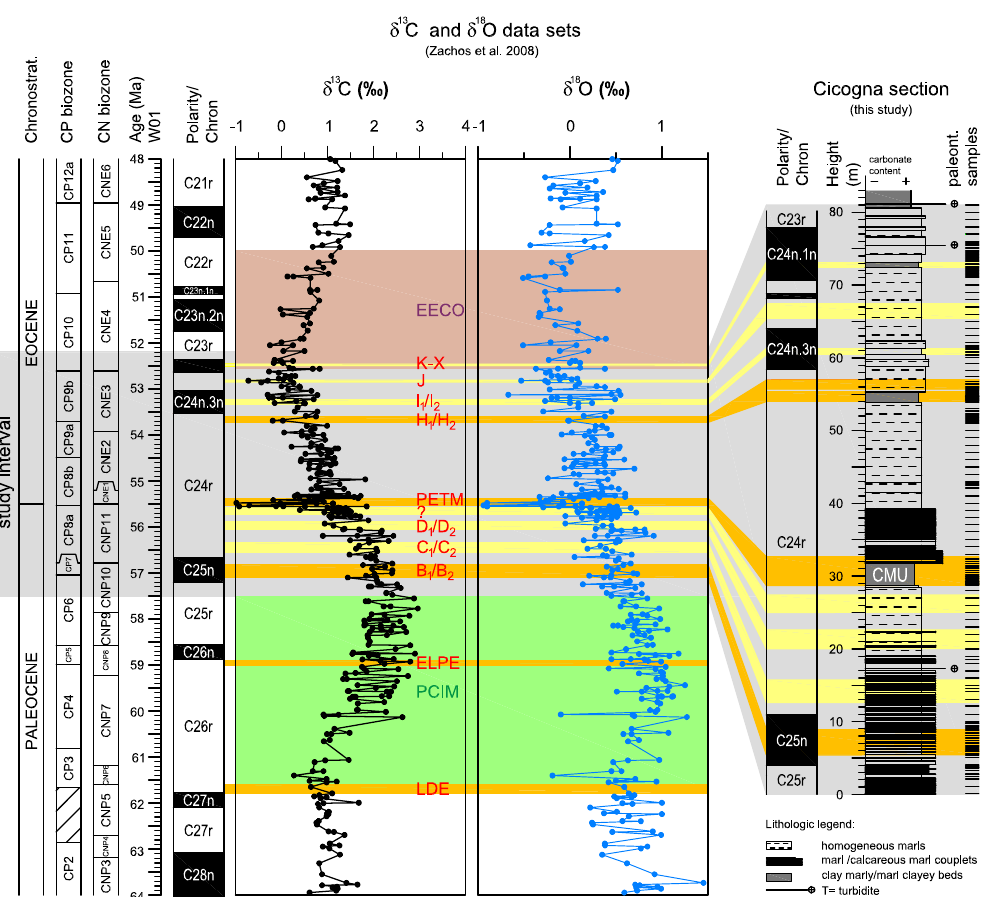
Figure 1. Middle Paleocene to middle Eocene (64 to 48Ma) stable isotope ( δ 13 C and δ 18 O) records of benthic foraminifera from multiple locations (Zachos et al., 2008) placed on the option 1 (W01) timescale of Westerhold et al. (2008). Also shown are positions of polarity chrons and calcareous nannofossil biozones for this time interval, both from the CP biozone scheme (Okada and Bukry, 1980) and the CN biozone scheme (Agnini et al., 2014). Various “events” are noted within this chronostratigraphic framework, including the Paleocene carbon isotope maximum (PCIM), the Paleocene–Eocene Thermal Maximum (PETM), the H-1/ETM-2 event, the K/X event, and the Early Eocene Climatic Optimum (EECO). To the right is the general lithologic column and magnetostratigraphy of the Cicogna section (Dallanave et al.,